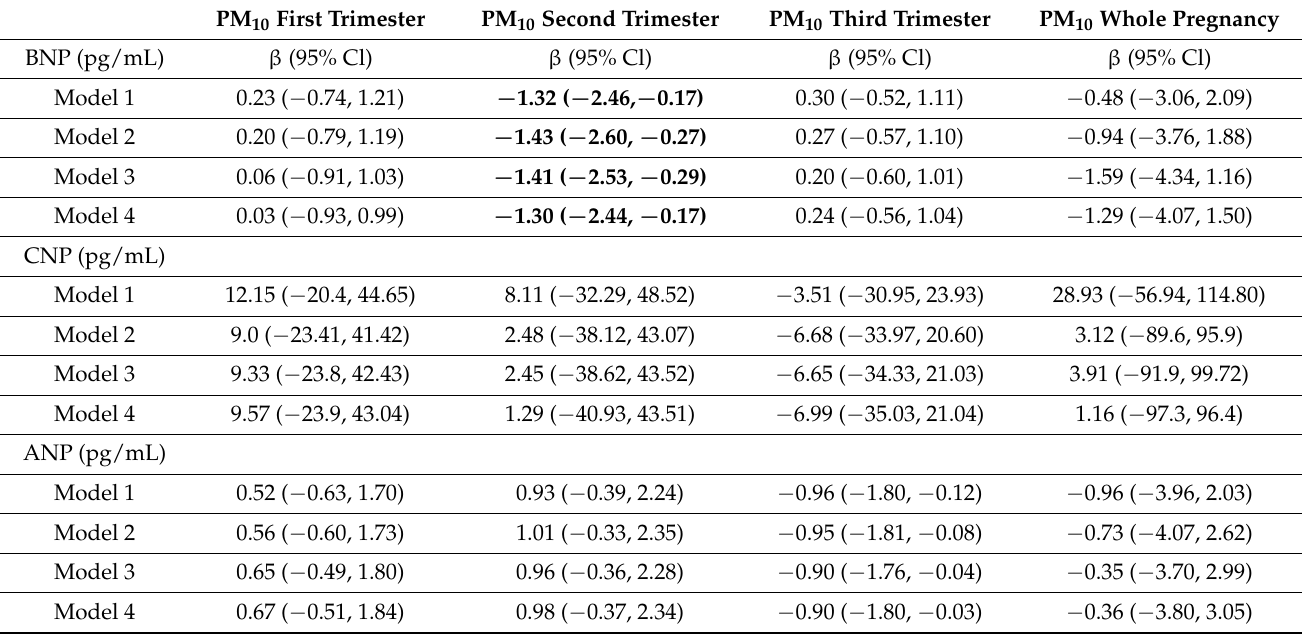
Model 1. Adjusted for maternal age, newborn sex, smoking before pregnancy. Model 2. Model 1 + occupation. Model 3. Model 1 + occupation + newborn weight. Model 4. Model 1+ occupation + newborn weight + newborn height. Significant results ( p < 0.05)